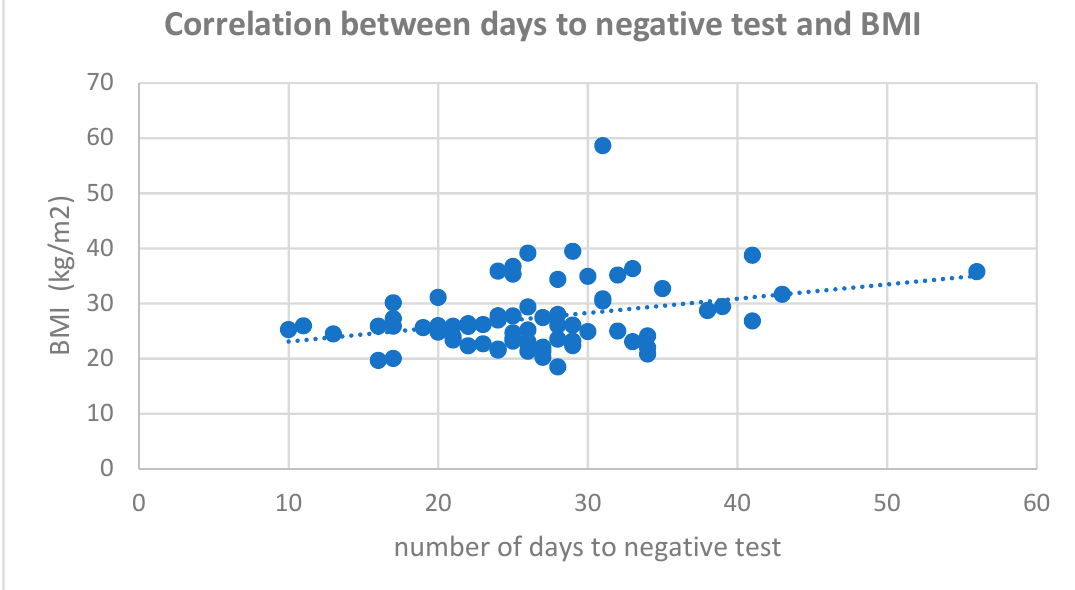
Figure 2. Correlation between days to negative test and BMI. Table 2. Clinical characteristics associated with longer RT-PCR SARS-CoV-2 positive testing.